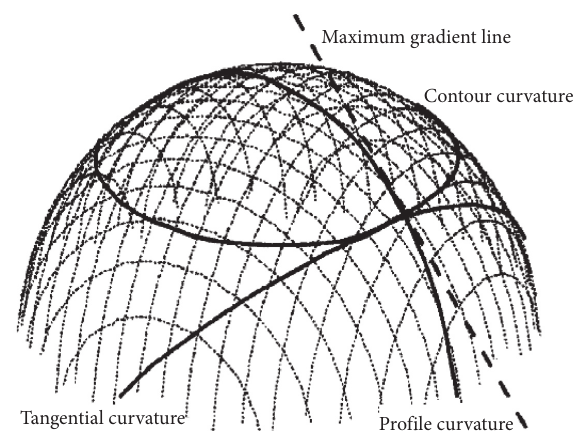
Figure 1: Definition of the profile, contour, and tangential curvature.